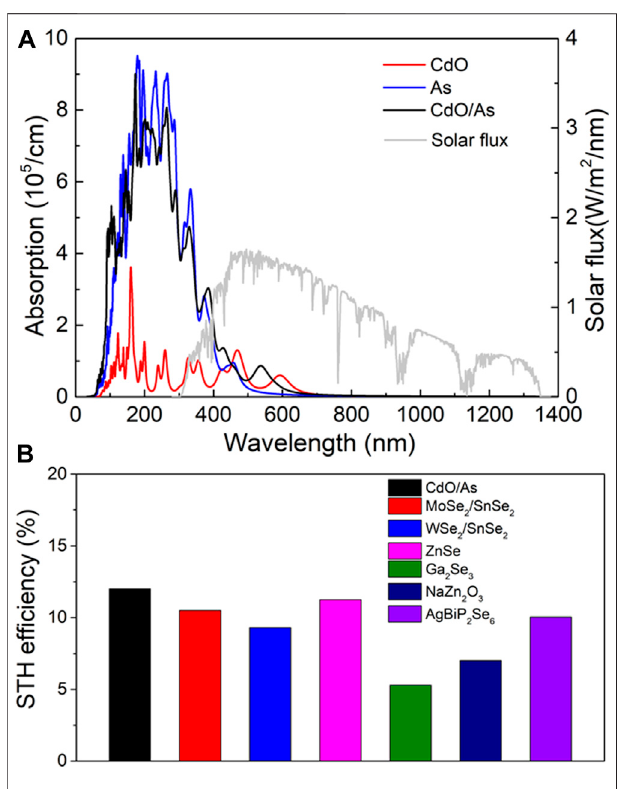
FIGURE 6 | (A) The HSE06 method obtained optical absorption spectrum and (B) the STH ef fi ciency of CdO/As vdW heterostructure comparing with other 2D materials (Fan et al., 2019; Jin et al., 2019; Yang et al.,